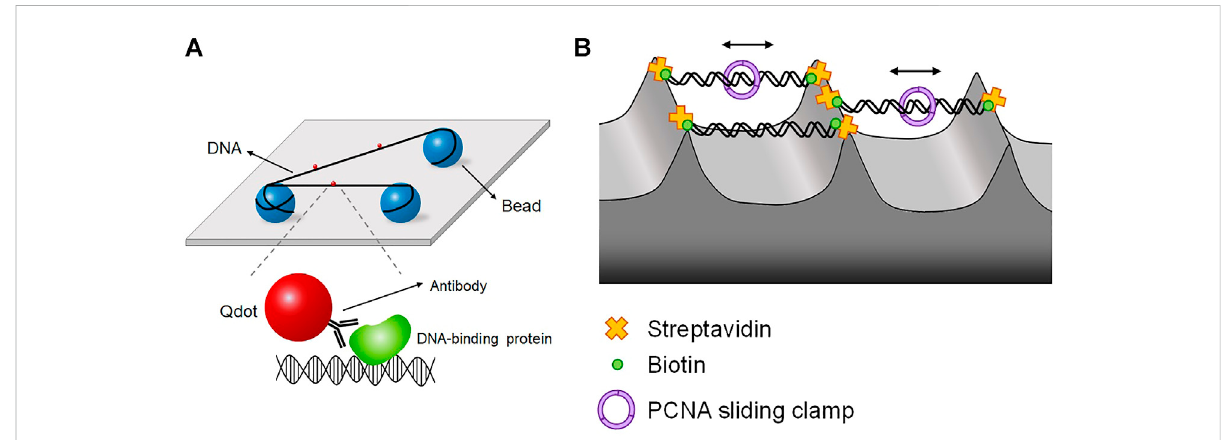
FIGURE 6 DNA tightrope and DNA skybridge. (A) DNA tightrope assay, in which DNA molecules are suspended between micrometer-sized beads and placed far above the surface, preventing the surface effect. Proteins are conjugated with Qdot, which is imaged by oblique angle excitation by laser instead of TIRFM. (B) DNA skybridge technique, in which biotinylated DNA molecules hang between streptavidin-coated apices of 3D microstructures, which are fabricated by photolithography and chemical etching. PCNA diffusion is observed in real time using DNA